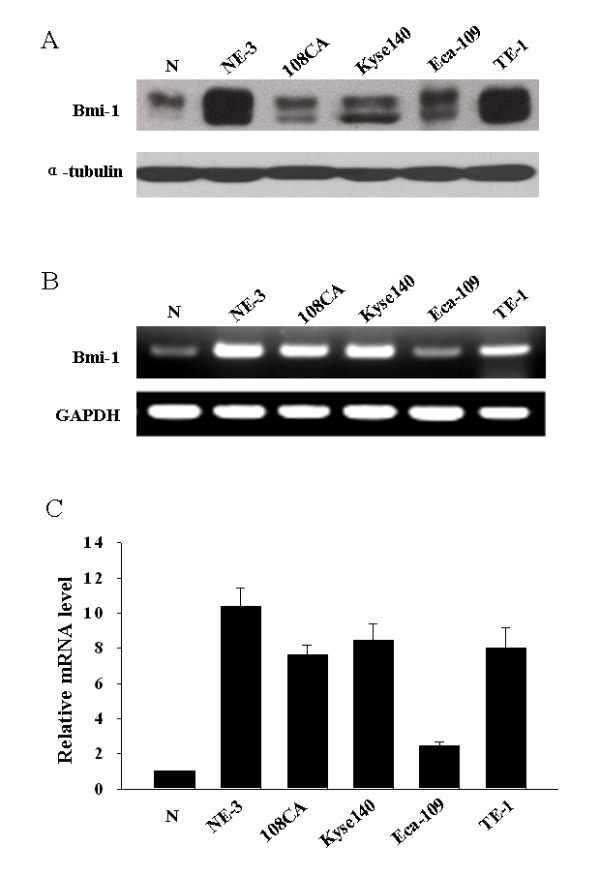
Overexpression of Bmi-1 in immortalized esophageal epithelial cell line and esophageal carcinoma cell lines. Expression of Bmi-1 protein (A), mRNA (B and C) in immortalized esophageal epithelial cell line (NE-3) and esophageal carcinoma cell lines (108CA, Kyse 140, Eca-109 and TE-1) analyzed by Western blot (A), RT-PCR (B) or real-time PCR (C). N was a normal esophageal tissue. Expression level was normalized by α-Tubulin or GAPDH. Error bars represent standard deviations (SD) calculated from three parallel experiments.